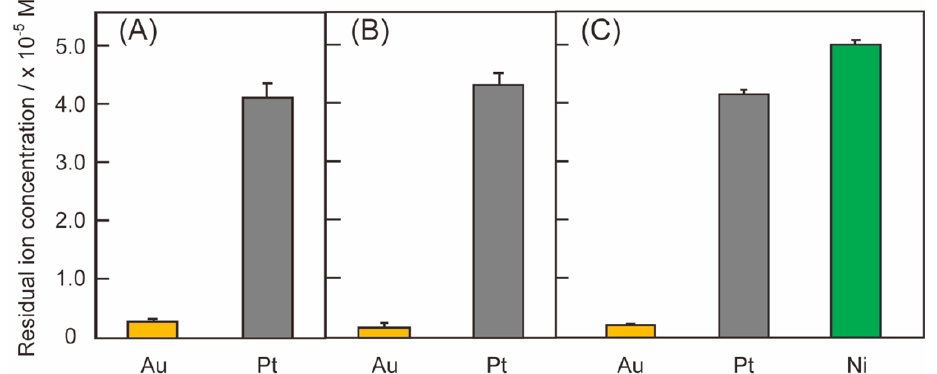
Figure 6. Quantification of residual Au, Pt, and Ni concentrations in supernatants from mixtures of HAuCl 4 and H 2 PtCl 6 (and Ni(NO 3 ) 2 for panel C) with ( A ) original RU065 ( a ) and ( B , C ) RU065 4–8 ( j ), as determined by IOC-OES analysis (mean ± SD, n = 3). Peptide = 2.0 × 10 − 4 M, HAuCl 4 = H 2 PtCl 6 = Ni(NO 3 ) 2 = 5.0 × 10 − 5 M in water. Reactions were conducted at 40 ° C for 24 h in the dark.